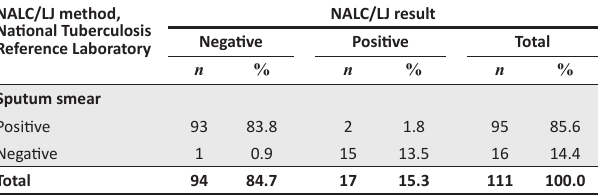
TABLE 3: Results ratio of mycobacterial culture and direct microscopy, Mozambique, 2014.